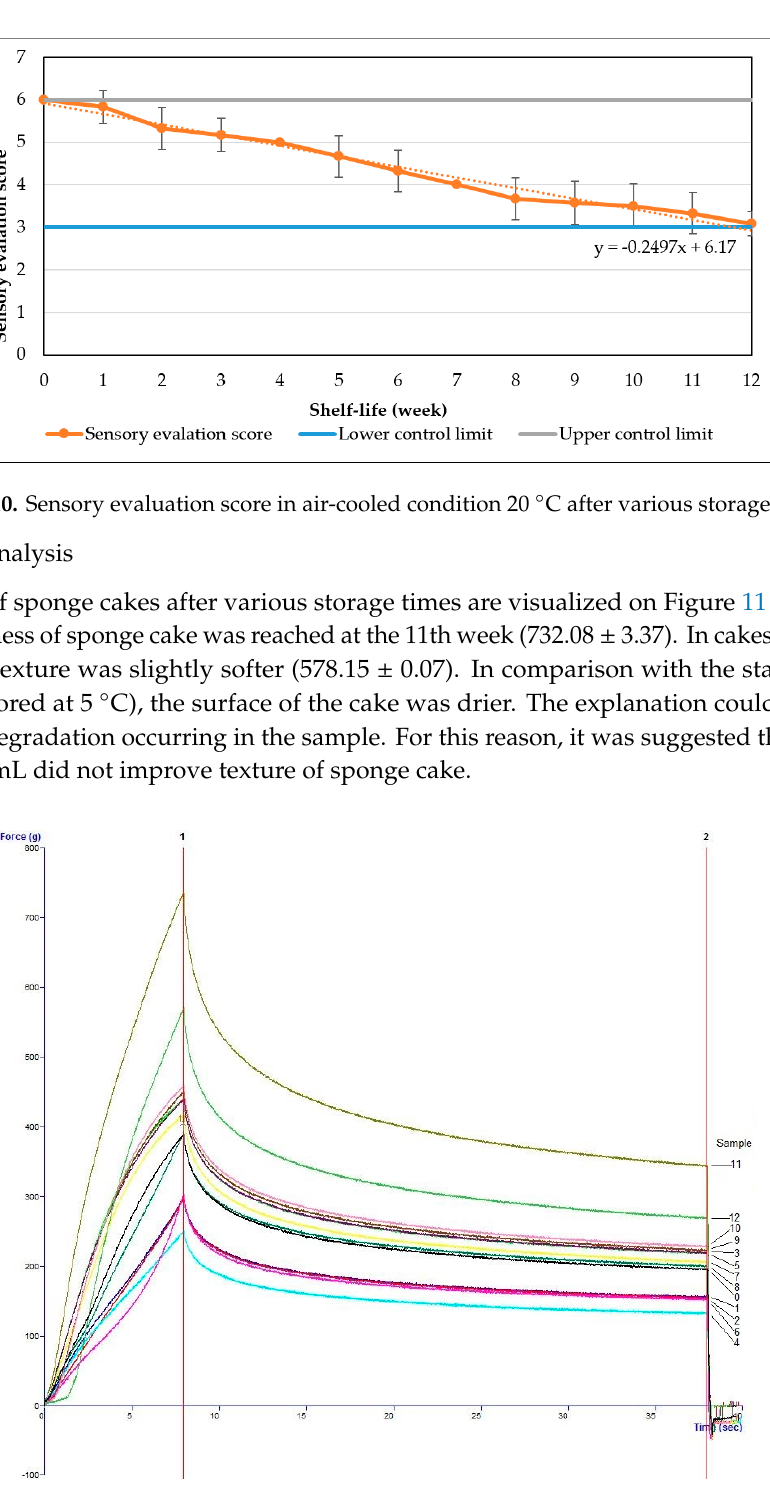
Figure 11. Firmness of sponge cakes in air-cooled condition 20 °C and after various storage times.